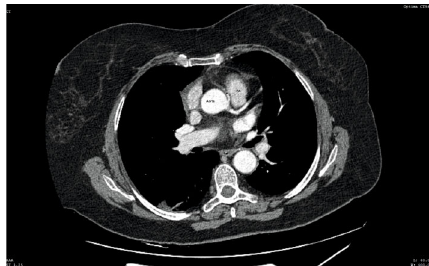
Figure 1: CT angiography of the aorta revealing an anomalous origin of the RCA (depicted with an “ ∗ ” ). The RCA exhibits an interarterial course between the aorta and the pulmonary artery (PA).